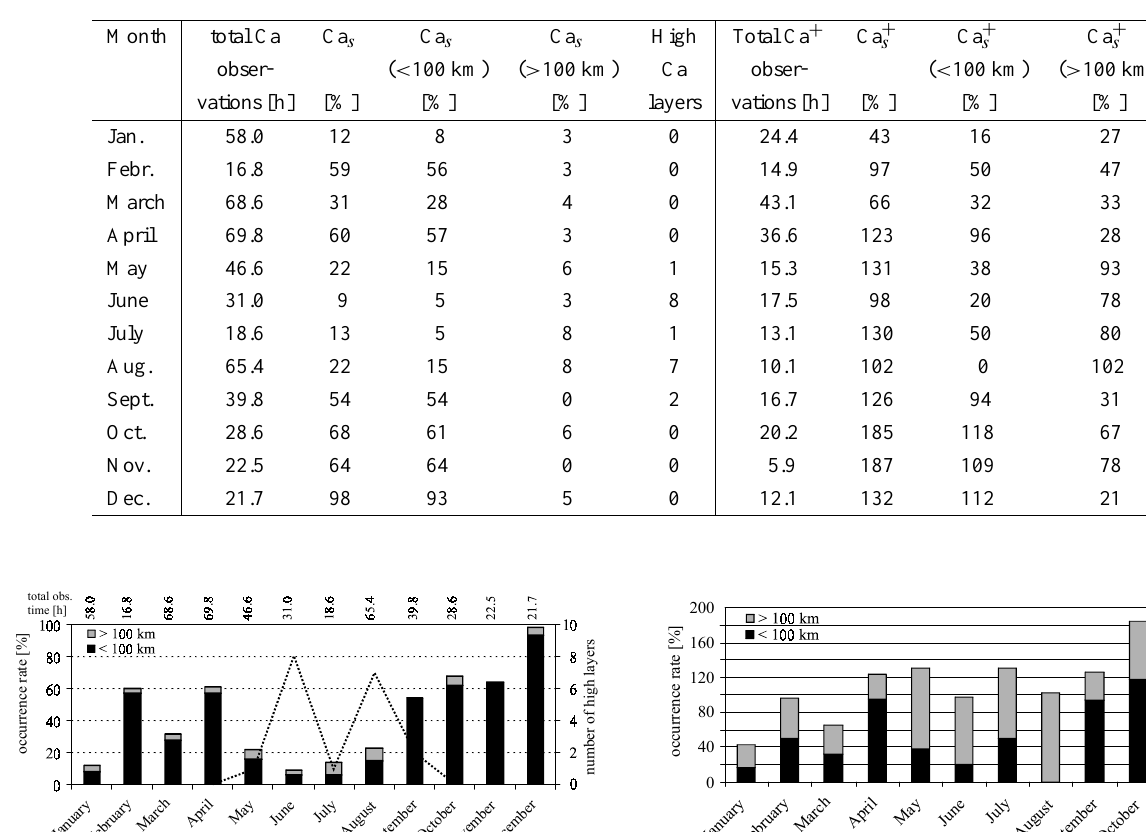
Table 2. Occurrence index of sporadic neutral and ionized Ca layers for each month of the year, based on 89 Ca s and 99 Ca + s , and of high Ca layers (for definition of the latter, see text)